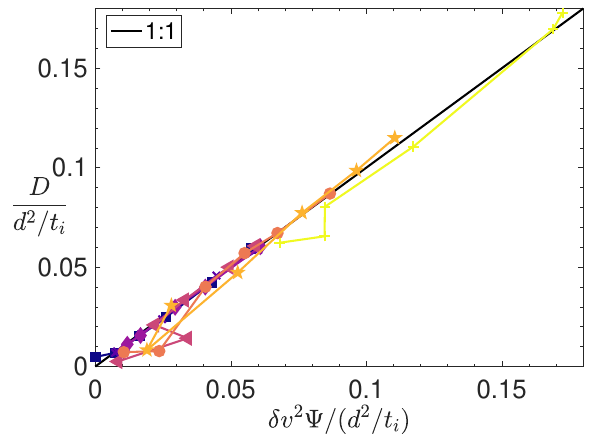
Figure 4. Di ff usivity D measured using (6) compared with the product δv 2 Ψ . The dashed lines represent the unity function for visual reference. Symbols represent di ff erent level of cohesion as per figure